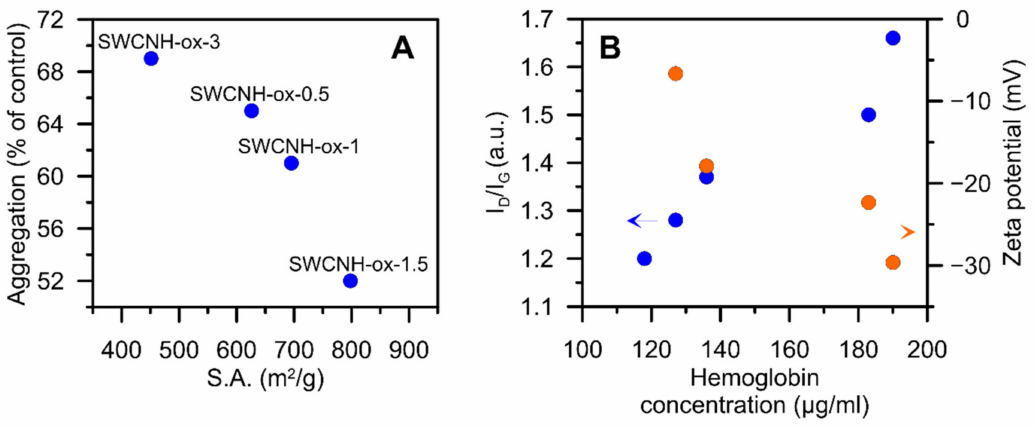
Figure 8. Correlation plots showing the dependence between ( A ) the aggregation of platelets and internal specific surface area [4] of SWCNH-ox materials and ( B ) the hemoglobin concentration from the hemolysis of porcine blood experiment and I D /I G ratio from Raman spectra [4] of SWCNH-ox materials. Data for the materials’ concentration at 100 µ